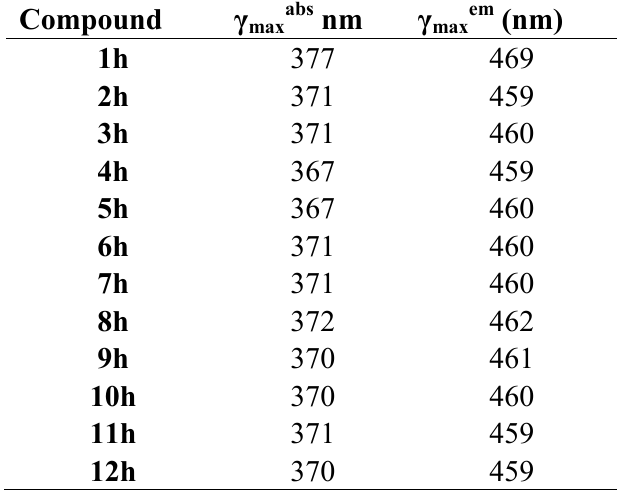
Table 1. Absorption and fluorescence wavelengths of compounds 1h − 12h